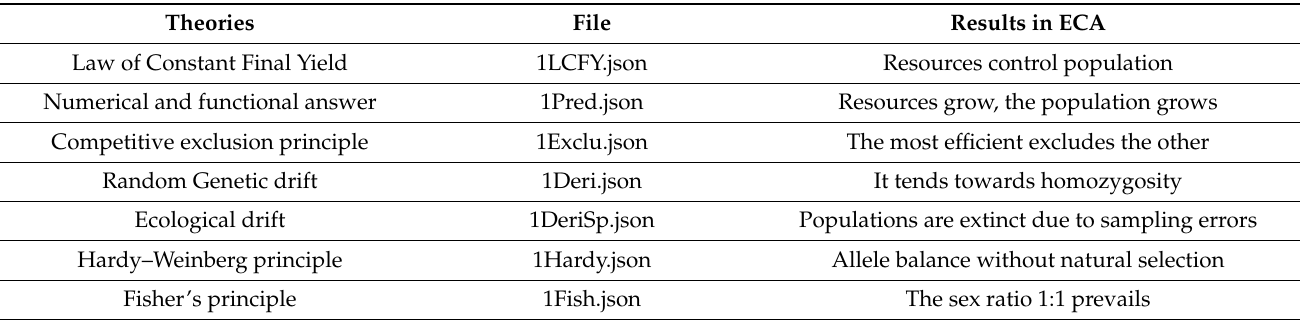
Table 4. Table summarizing simulations to verify principles and evolutionary